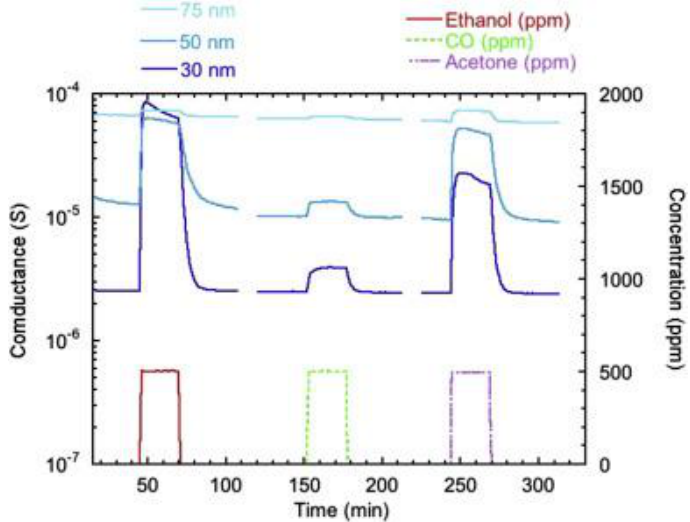
Figure 14. Dynamical response of Nb-doped TiO 2 nanotubes towards 100 ppm of ethanol, carbon monoxide and acetone at a working temperature of 400 °C and 40%RH@20 °C for different internal tube diameters. Reproduced with permission from [21]. Copyright (2015) Elsevier Inc.